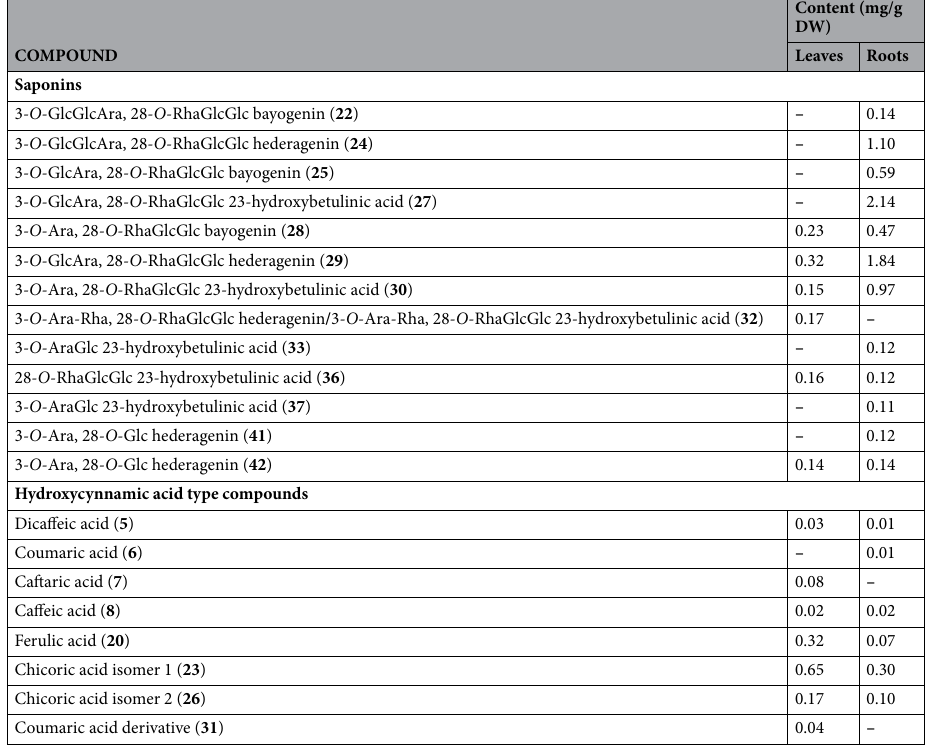
Table 3. Content of saponins and hydroxycynnamic acid type compounds in P. patens extracts. Ara – arabinose; Glc – glucose; Rha – rhamnose; DW – dry